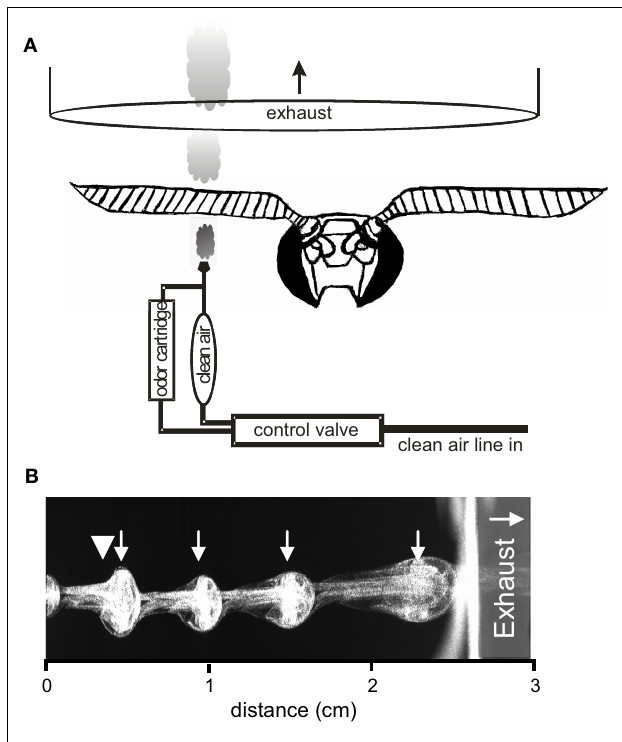
FIGURE 1| Schematic of the general experimental setup in Experiments 1–3. (A) A single line feeds air into the valve and can be switched between the blank and the odor cartridges, which merge about 2 mm before the output nozzle. (B) High speed imaging of olfactometer output at 50 Hz with a velocity of 0.3 m/s and a 10:40-ms duty cycle. Titanium tetrachloride, which produces a neutrally buoyant condensate, was used to visualize this 50-Hz pulse train. The odor nozzle is just out of view to the left. The large arrowhead indicates where the antenna was placed during physiological experiments. Small inset arrows identify individual pulses. Because some titanium tetrachloride condenses at the tip of the nozzle, there is a constant stream even when the valve is not open. Note also that as individual pulses approach and pass through the opening of the exhaust (vertical white line) they are stretched indicating that the draw is faster than the puffi ng